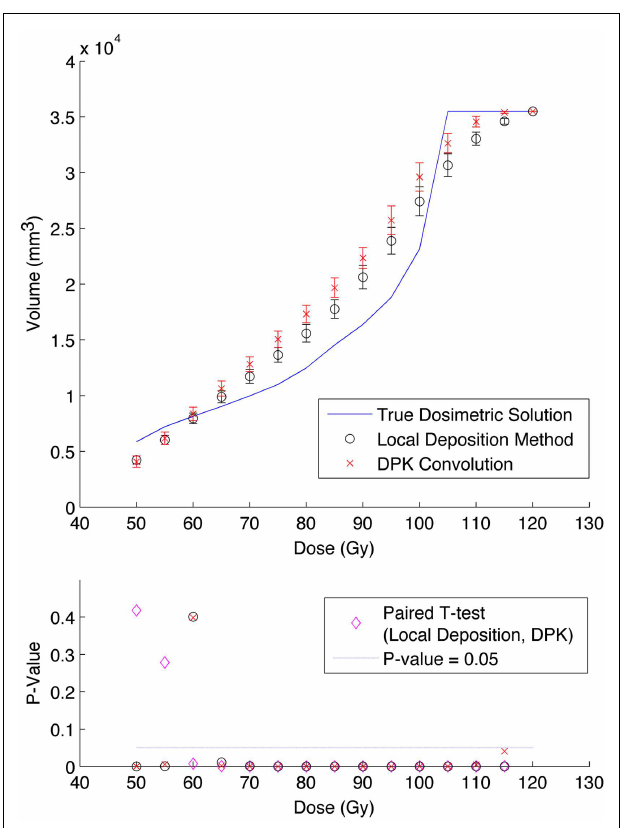
FIGURE 7 |Top: IDVH of NEMA phantom 17mm hot-sphere comparing DPK convolution and the local deposition method, as determined from 6, 40min scans according to recon 3 inTable 1 . Reconstruction was performed using 2mm isotropic voxels with 1 iteration, 21 subsets, and TOF + RR. Both experimental IDVH are compared to the true dosimetric solution IDVH. Bottom: error